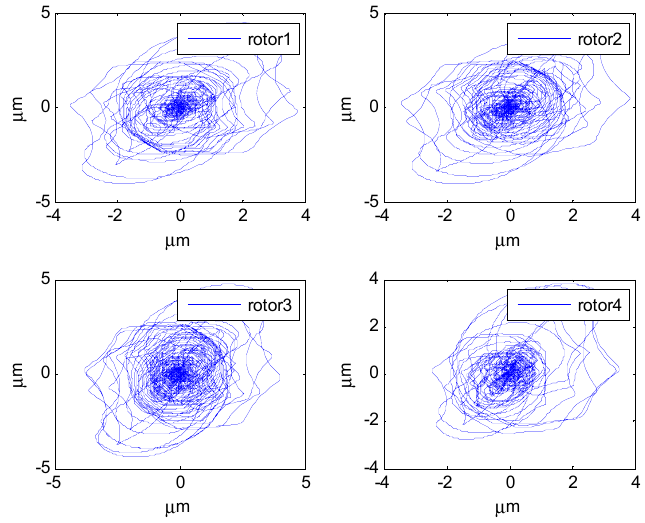
Figure 15. The rotor displacement with feedforward compensation.